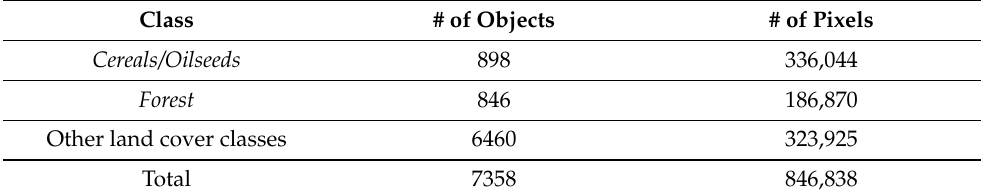
Table 1. Haute-Garonne ground truth